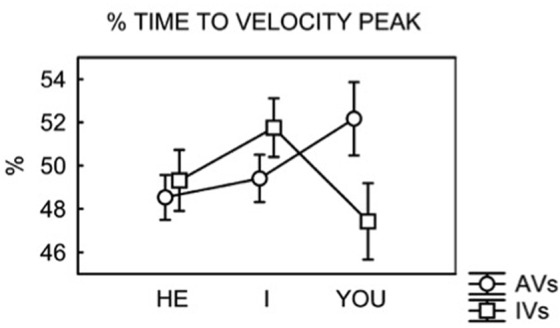
% of Time to velocity peak, interaction between perspective and verb type. Bars are SE.